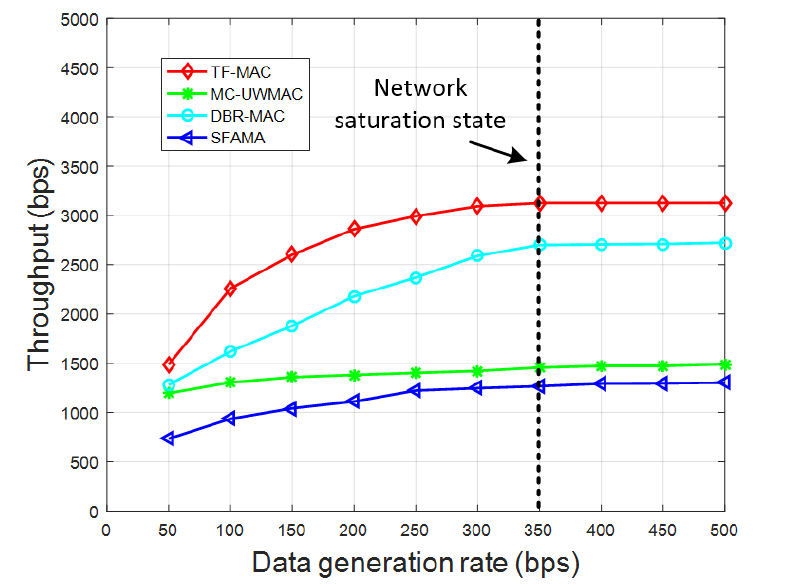
Figure 13. Comparison of throughput in the sparse network.